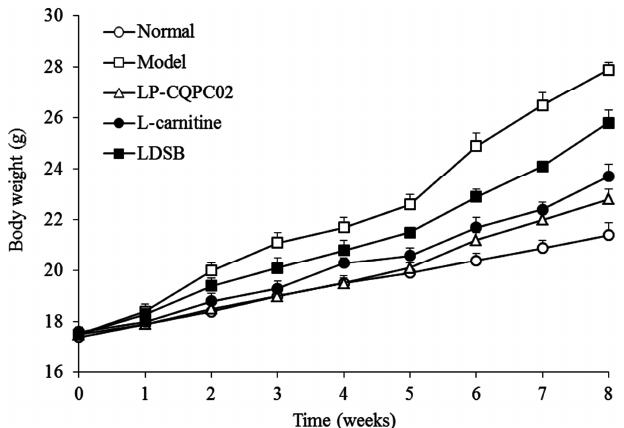
Figure 1. Body weight of mice during the experiment. LDSB: Mice treated with 1.0 × 10 9 CFU/kg of Lactobacillus delbruechii subsp. bulgaricus ; LP-CQPC02: Mice treated with 1.0 × 10 9 CFU/kg of Lactobacillus plantarum CQPC02; L -carnitine : Mice treated with 200 mg/kg of L -carnitine.